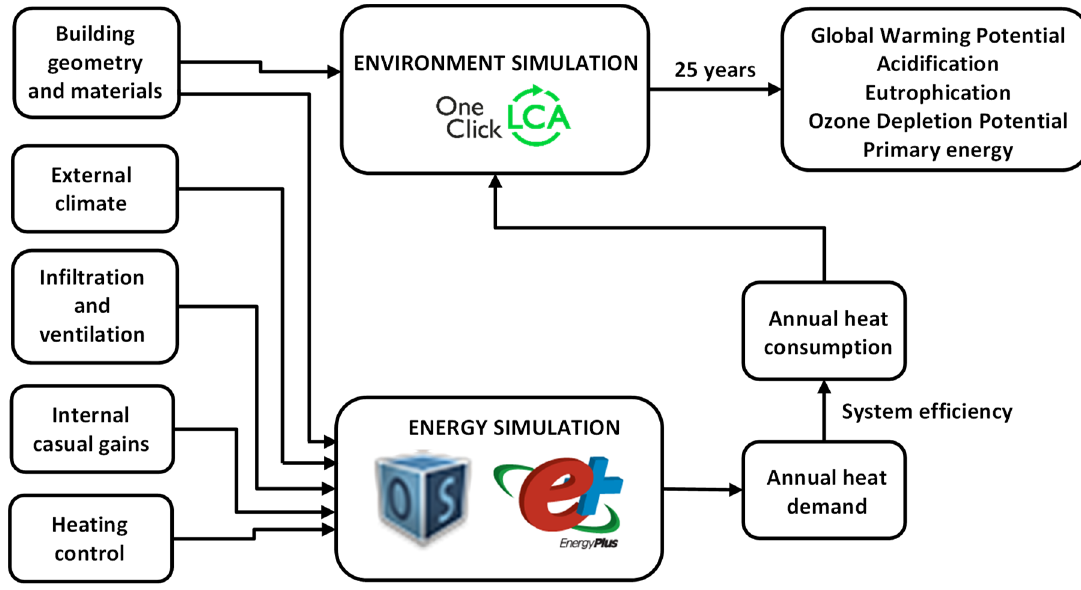
Figure 3. Calculation scheme.